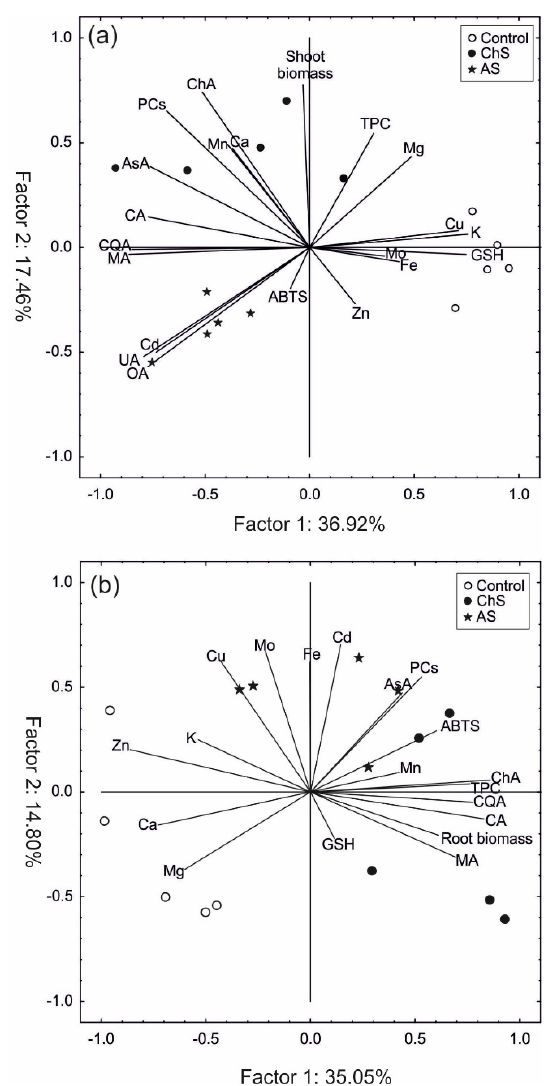
Figure 7. Scaled scatter plot of principal component analysis of selected secondary metabolites (ChA—chlorogenic acid; CQA—3,5-dicaffeoylquinic acid; UA—ursolic acid; OA—oleanolic acid; TPC—total phenolic content), thiol-peptides (GSH—glutathione; PCs—phytochelatins), organic acids (MA—malate acid; CA—citrate acid), antioxidant capacity (ABTS), biomass, macro- and microelements in the shoots ( a ) and roots ( b ). The length of lines shows a correlation between original data and factor axes.